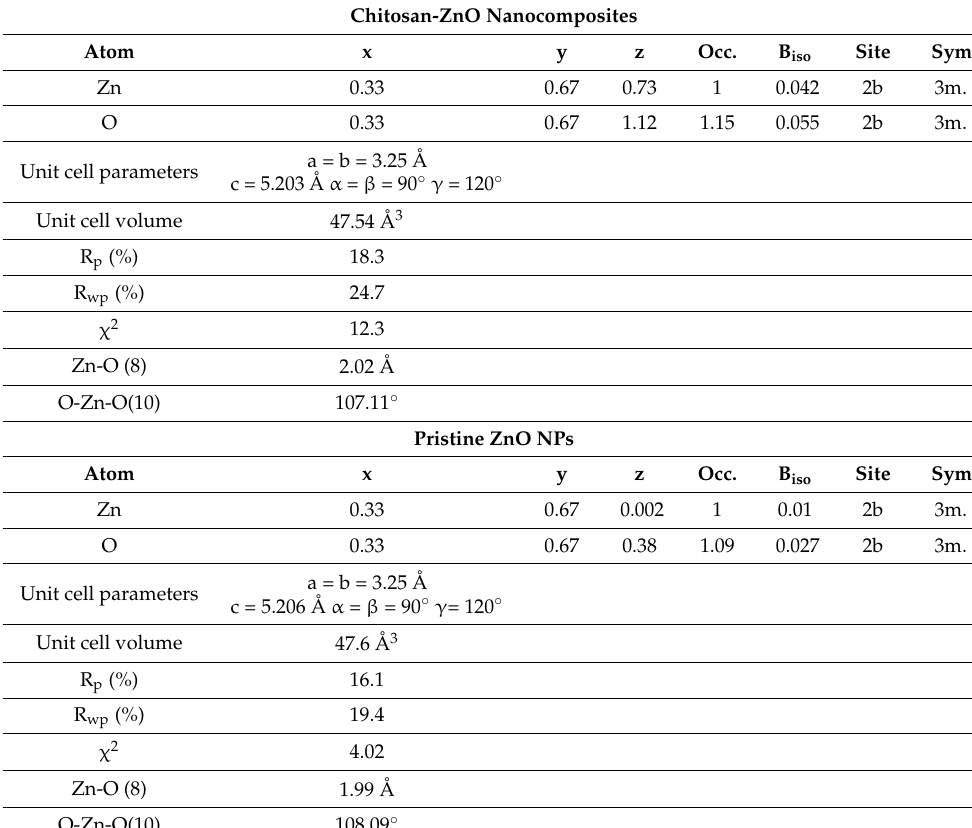
Table 3. Unit cell parameters of ZnO NPs and Chitosan-ZnO nanocomposites.